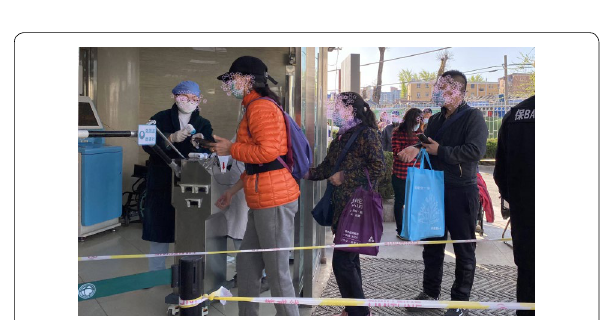
Figure 9 SHUYUmini robot used in the First Affiliated Hospital of Tsinghua